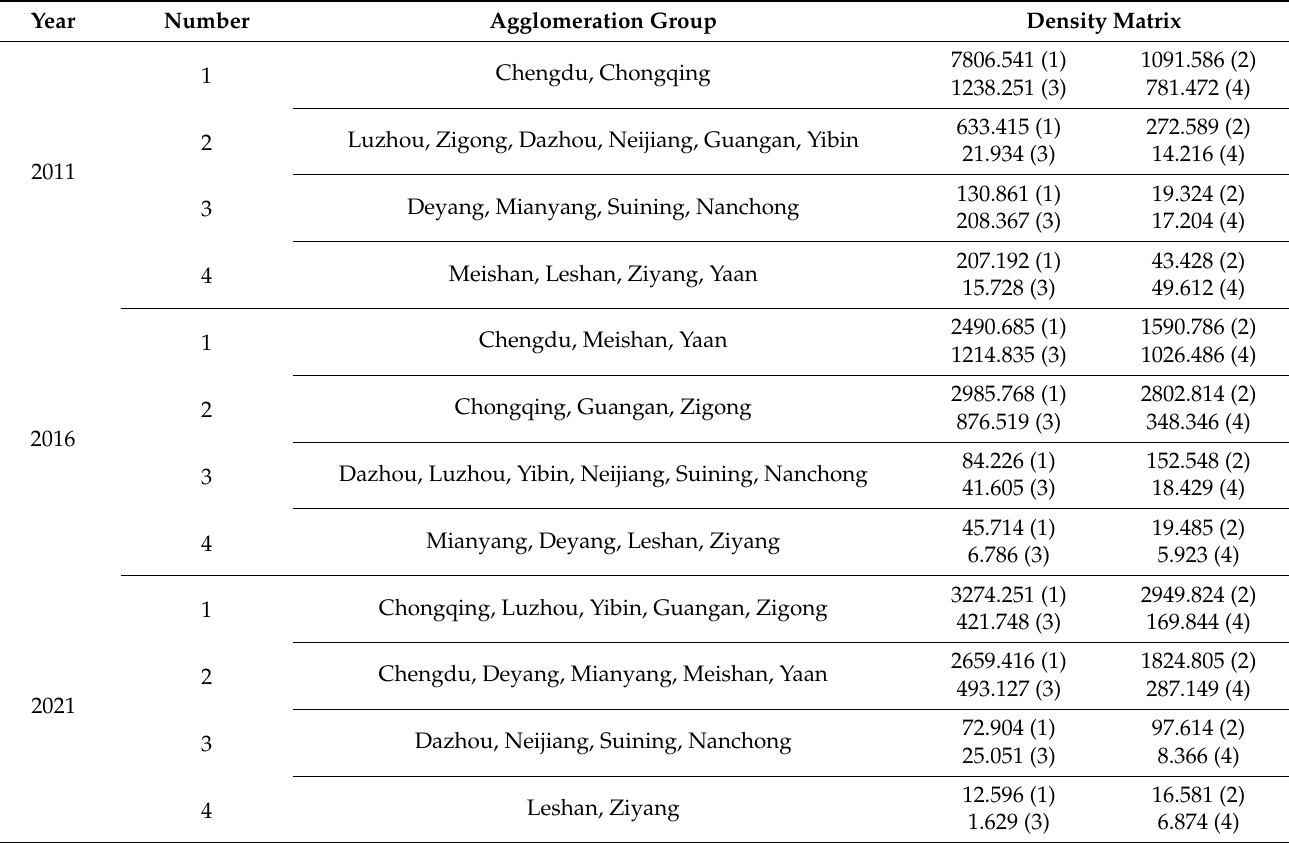
Table 3. Agglomeration groups of the economic relations network of Chuanyu city